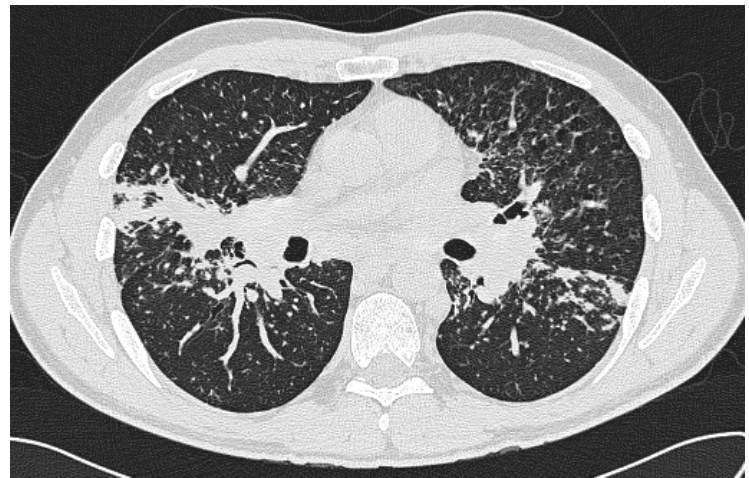
Figure 7. CT scan of SAIA with widespread consolidation.